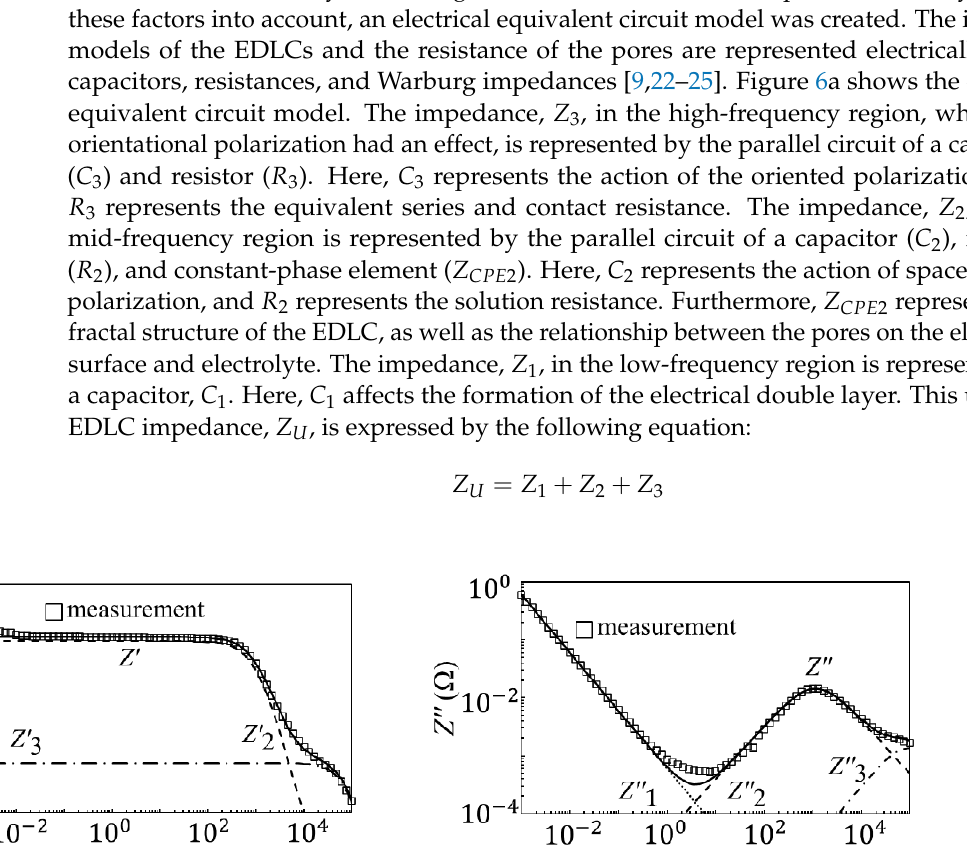
( b ) Figure 6. Equivalent circuit model. ( a ) Equivalent circuit model of the unused EDLC. ( b ) Equiva- lent circuit model of the degraded EDLC. Figure 6b shows the equivalent circuit model of the degraded EDLC. As mentioned previously, there was a notable difference between the impedance of the unused and de- graded EDLCs in the low- to mid-frequency region, and this factor played a role in the degradation. The degradation factor can be expressed by a new constant-phase element, i.e., 𝑍 (cid:3004)(cid:3017)(cid:3006)(cid:2872) . The 𝑍 (cid:3004)(cid:3017)(cid:3006)(cid:2872) parameter represents the slope of the impedance of the degraded EDLC in the low- to mid-frequency region, and the position of 𝑍 (cid:3004)(cid:3017)(cid:3006)(cid:2872) is between 𝑍 (cid:2869) and 𝑍 (cid:2870) . The degraded EDLC impedance, 𝑍 (cid:3005) , can be expressed as follows: 𝑍 (cid:3005) = 1 𝑗𝜔𝐶 + 𝑍 (cid:3004)(cid:3017)(cid:3006)(cid:2872) +